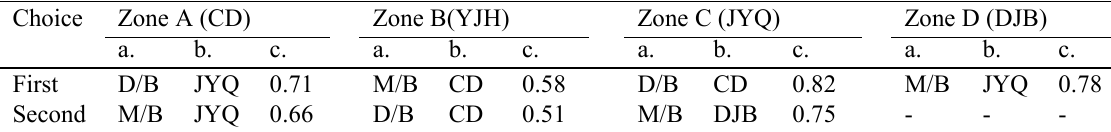
Table 7 Suggestions for acquiring the discharge for ungauged station in USMRB.